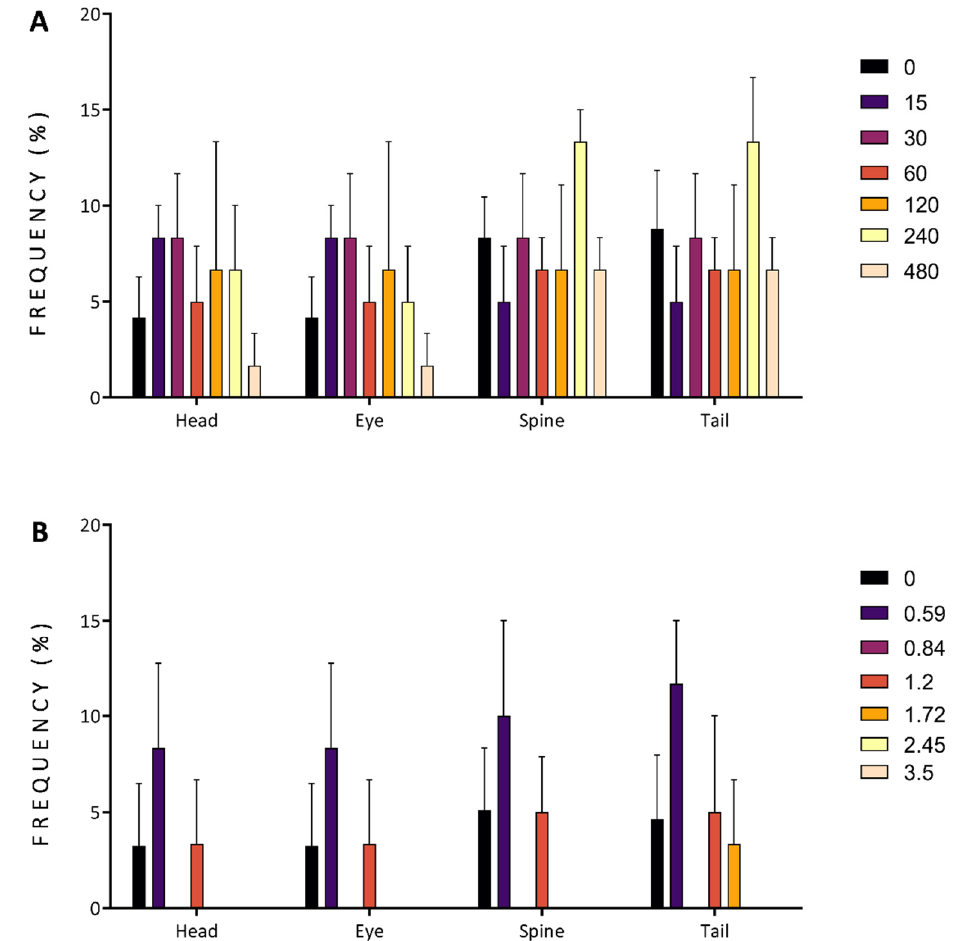
Figure 6. Malformations observed in zebrafish exposed at 96 h post-fertilization to different concentrations of finger lime and mountain pepper extracts. Each colour bar denotes the concentration tested in mg/L for finger lime ( A ) and mountain pepper ( B ). Malformations were mainly observed in the head, eyes, spine and tail. No statistically significant difference was observed when comparing the exposed and control groups for both finger lime and mountain pepper, and no malformations were observed for tamarind. Data represent the mean ± SD, n = 60.